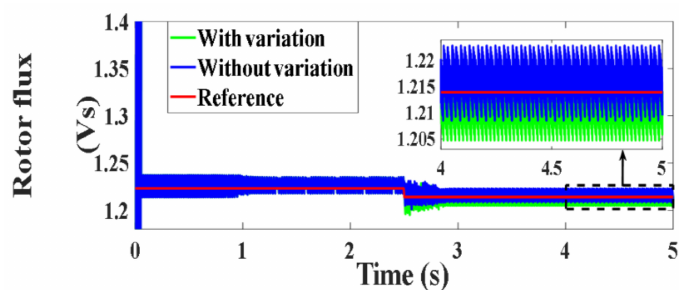
Figure 136. Rotor flux under PVC (Vs).